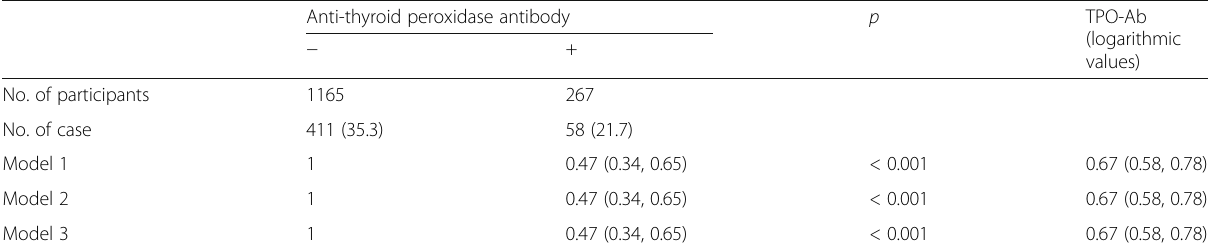
(logarithmic values)